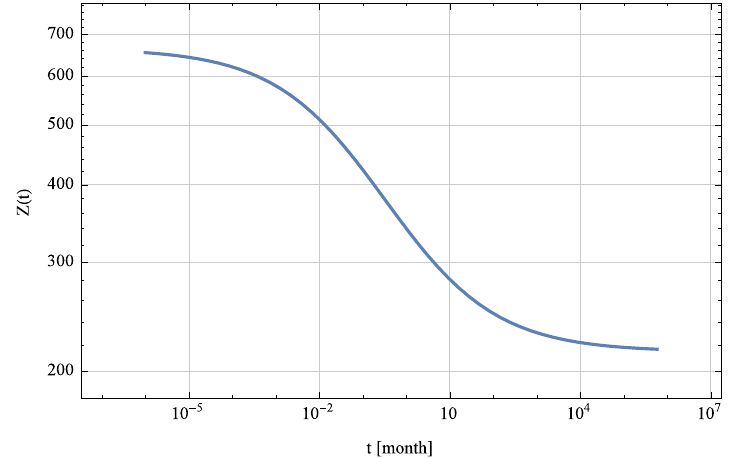
Figure 13. Time dependent impedance Z ( t ) derived from the inverse Laplace transform of the